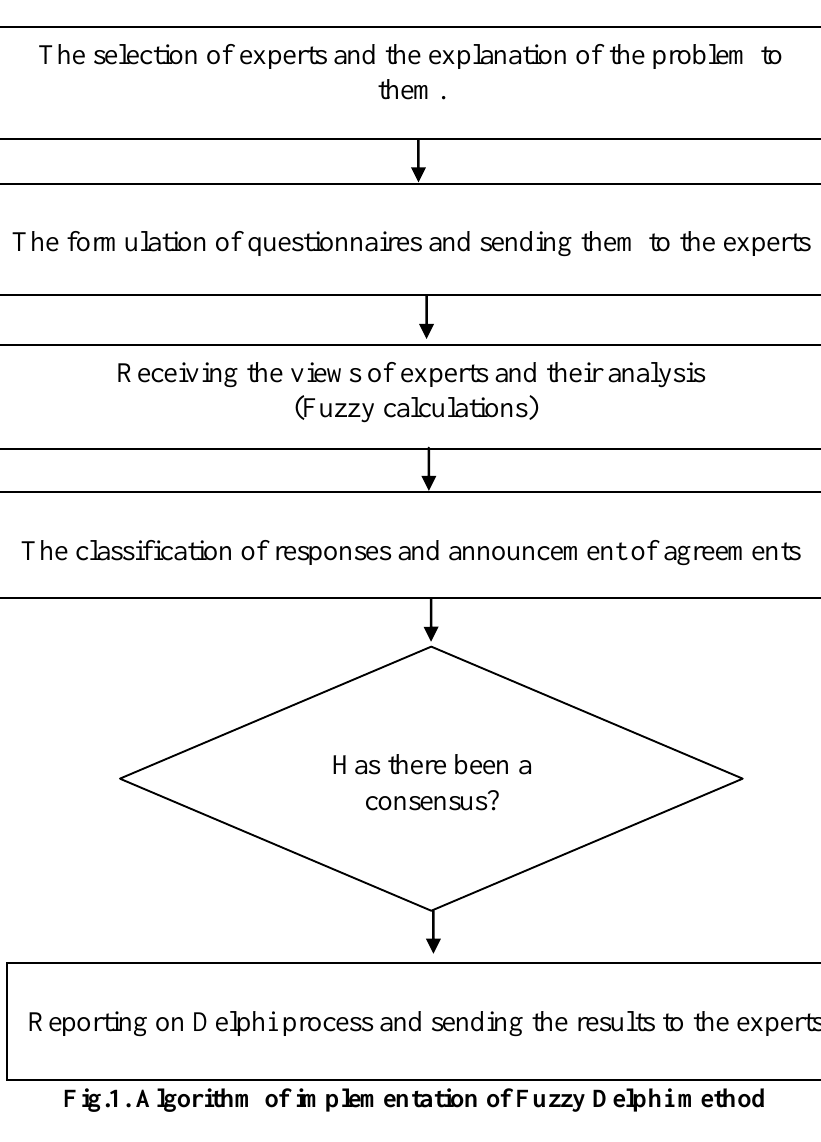
Fig.1. Algorithm of implementation of Fuzzy Delphi